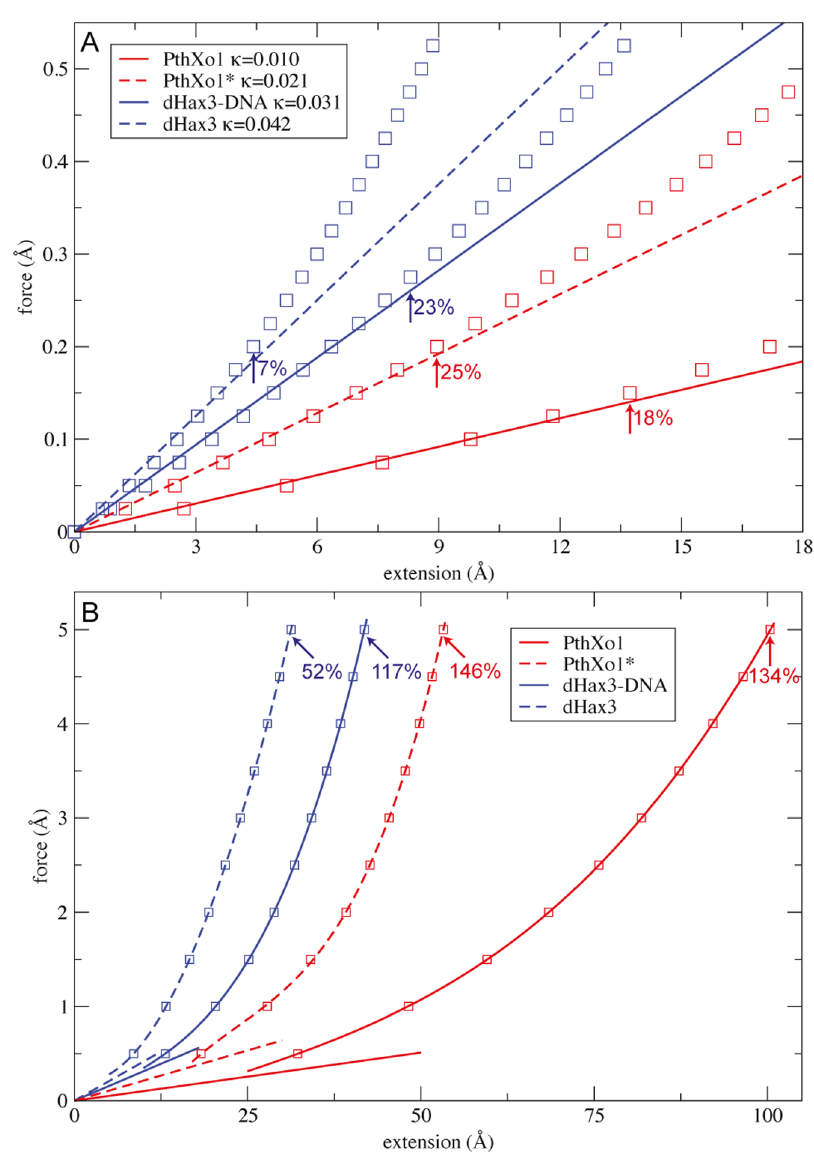
Figure 2. Force-extension relation for the four studied TALEs. A: Linear regression of the data and the derived stiffness constants are shown; the estimated validity range in terms of relative extensions (see Methods) is indicated for each TAL structure. B: Non-linear super-proportional force extension curves for large TALE deformations. For the force of magnitude F =5.0 A˚, the relative protein extensions are given.